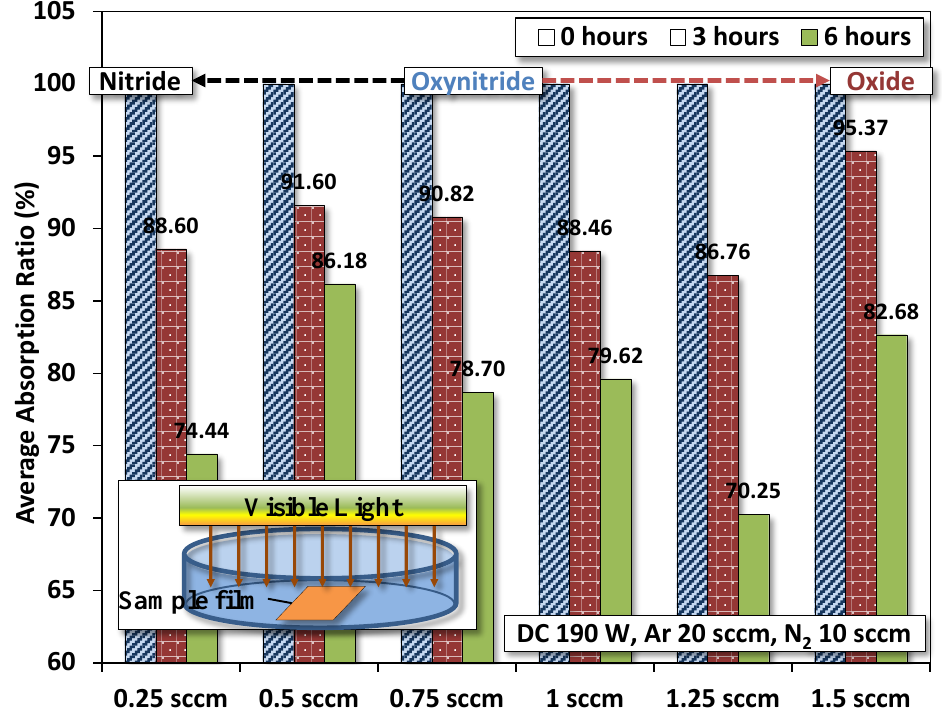
Figure 9. Photodegradation of methyl orange by various annealed oxynitride films under visible light.